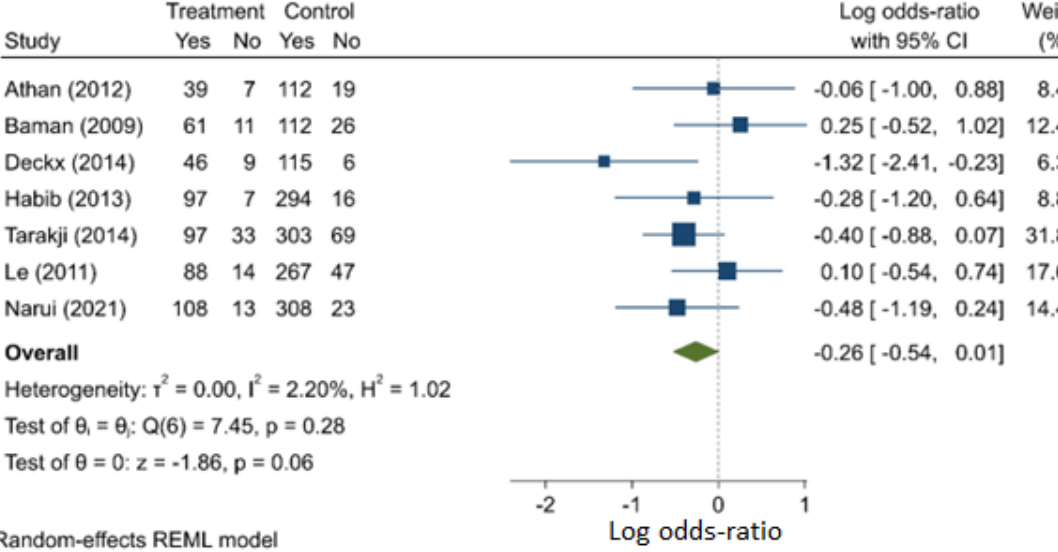
Figure 5. Males compared with females as a risk factor for mortality.